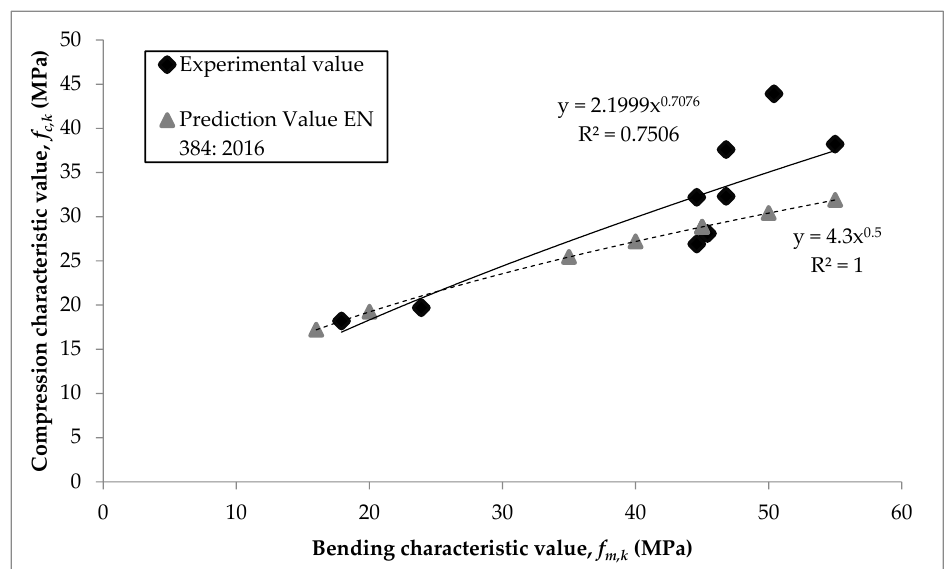
Figure 8. Relationship between experimental and derivative compressive and bending strength characteristic values.